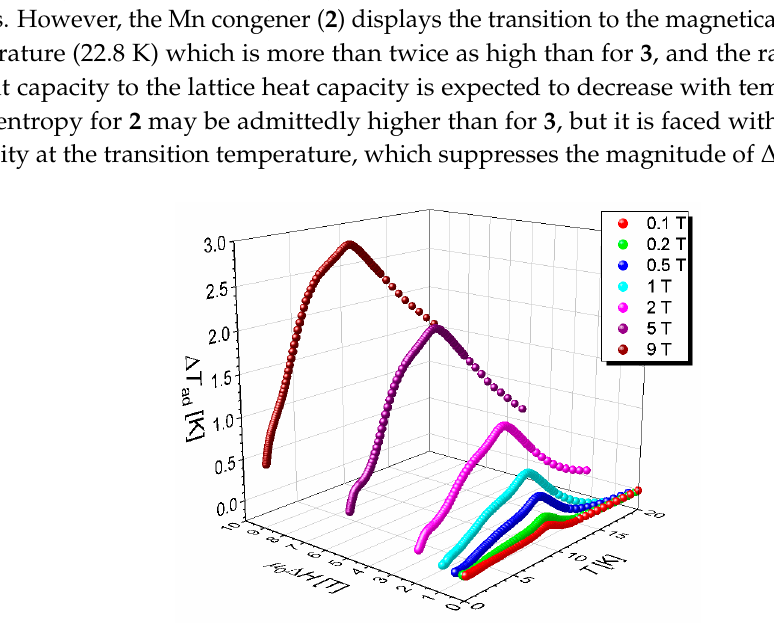
Figure 18. Temperature dependence of Δ T ad for 3 .